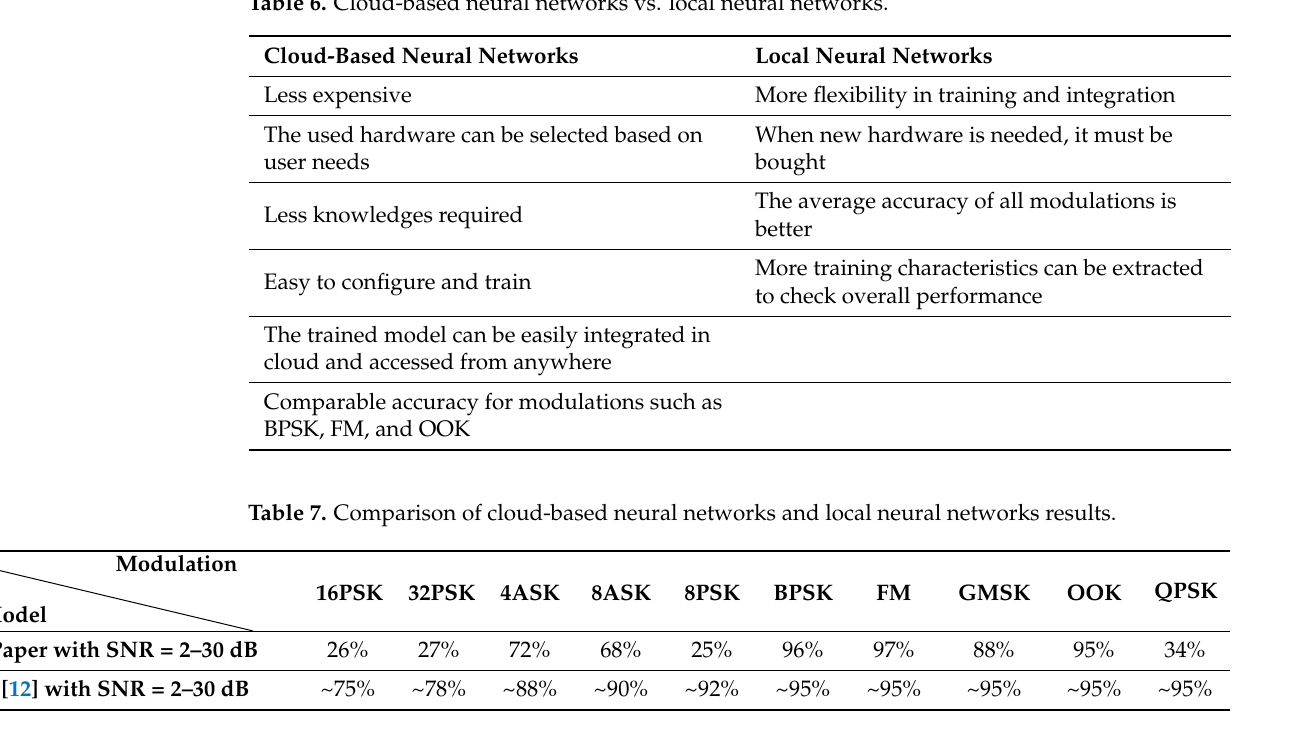
Table 6. Cloud-based neural networks vs. local neural networks.